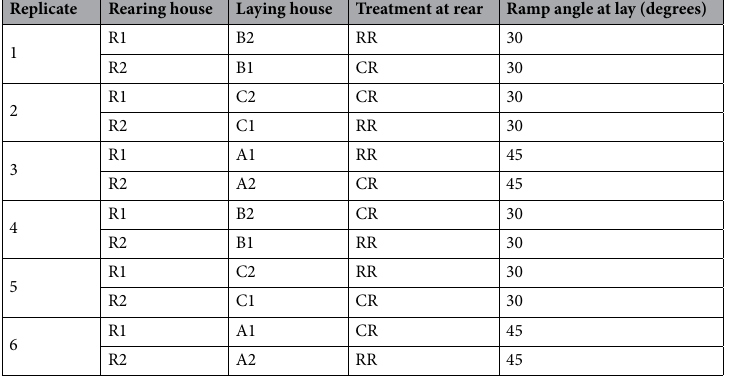
Table 5. Experimental design for each ramp reared and control reared flock for the 6 replicates. There were two rearing sheds used, Rear1 (R1) and Rear2 (R2), with 6 different laying sheds named A1, A2, B1, B2, C1 and